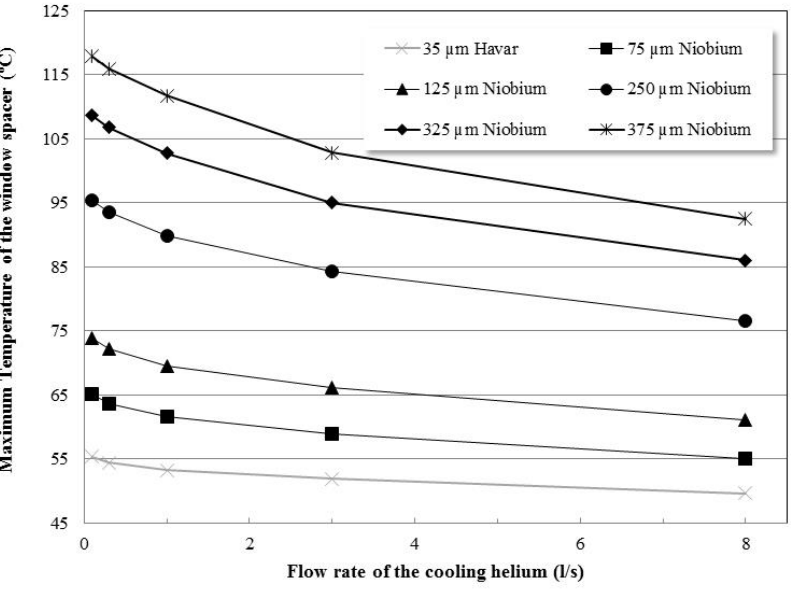
Figure 27. Maximum temperatures of the window spacer as a function of the flow rate of the cooling helium, for different target windows.